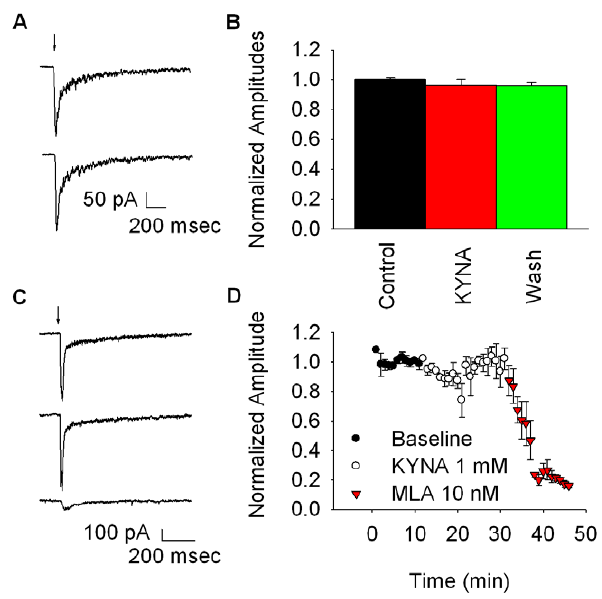
Figure 3. KYNA effects on a 7* responses in mouse and rat CA1 stratum radiatum interneurons. Panel A shows representative traces for choline-evoked a 7* currents in mouse stratum radiatum interneurons. The top trace is the control response to pressure applied choline (10 mM, 50 ms). The bottom trace shows the choline response after 30 min bath exposure to 1 mM KYNA. Panel B shows the summarized results. KYNA failed to reduce the choline response (t=0.8565, df =4, p = 0.44, n=5, paired t-test). Panel C shows representative traces for pressure applied choline-evoked a 7* currents in rat stratum radiatum interneurons. The top trace shows the control response to 10 mM choline. The middle trace shows the ACh response after 30 min bath exposure to 1 mM KYNA. The bottom trace shows the ACh response after 20 min bath exposure to 10 nM MLA. Panel D shows the summarized results for these experiments. For this analysis, the last five traces were averaged for each condition: control, KYNA, and MLA. KYNA failed to block the choline-induced a 7* currents (t=0.3994, df=4, p=0.71, n=5, paired t-test) while MLA blocked significantly the response (t=15.5441, df=4, p=0.0001, n=5, paired